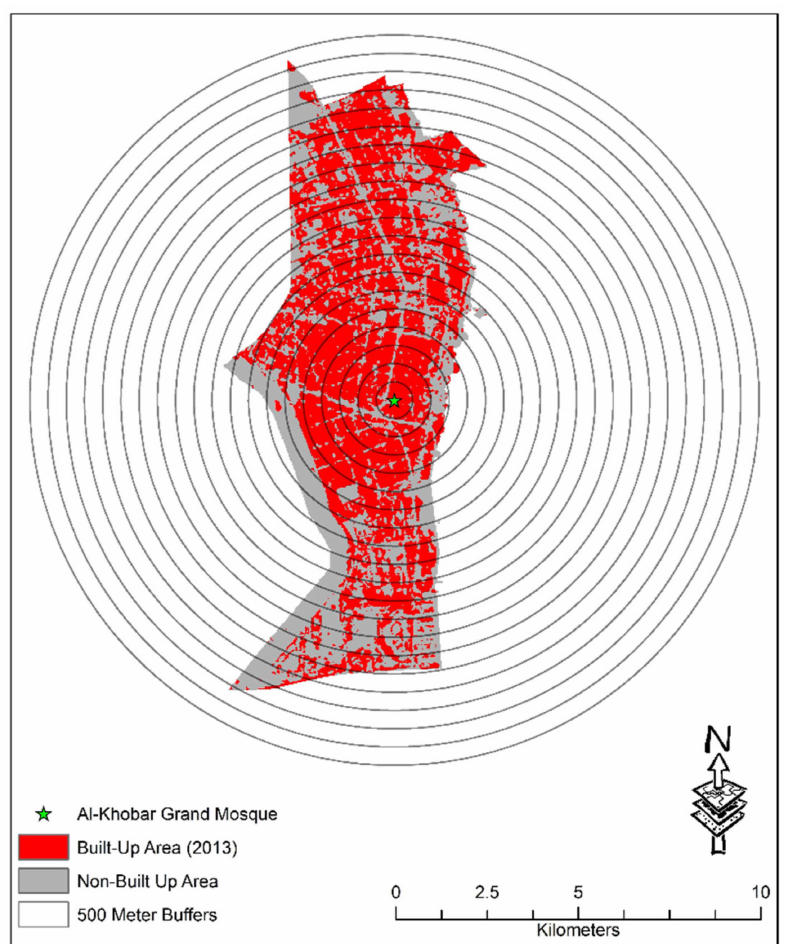
Figure 2. Buffer zones around the Al-Khobar osque used to calculate relative Shannon’s entropy index